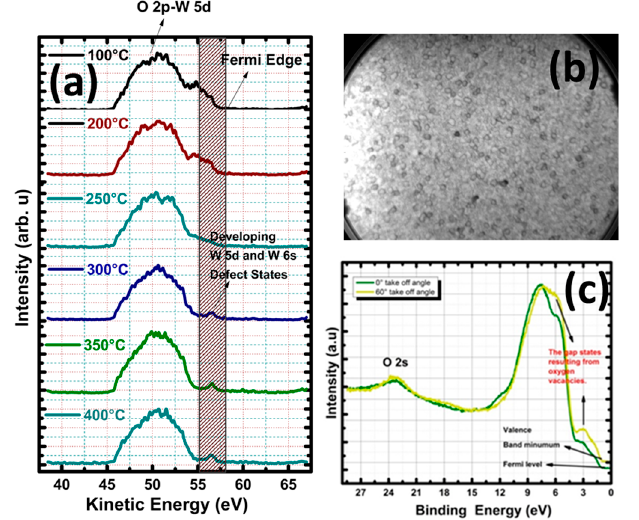
Figure 1. Valance band spectrum of WO 3 25 °C–400 °C ( a ) LEEM images of 700 °C deposited WO 3 , at FoV of 12.4 µm with 5 eV KE ( b ), Valence band region of MoO x ultra-thin film in the vicinity of Fermi level with 60 eV photons at two different electron take-off angles 0° and